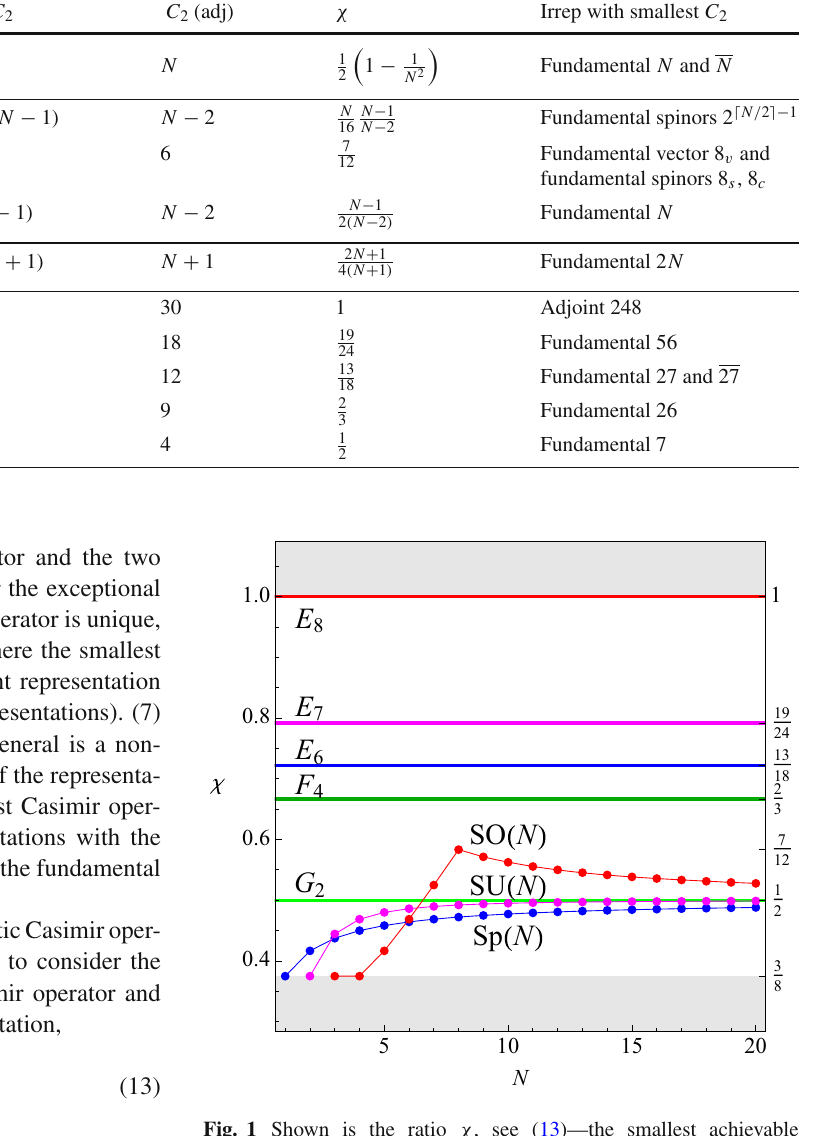
Table 1 Summary of minimal Casimir operators for the classical and exceptional Lie algebras along with the Casimir operator in the adjoint representation, their ratio χ , and the representations that attain the min- Symmetry